Question: Which kind of chart has been used to present this data?
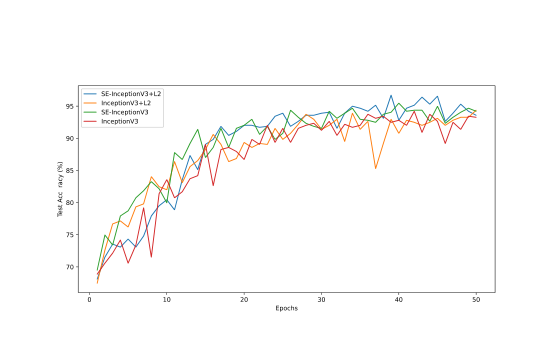
Answer: line